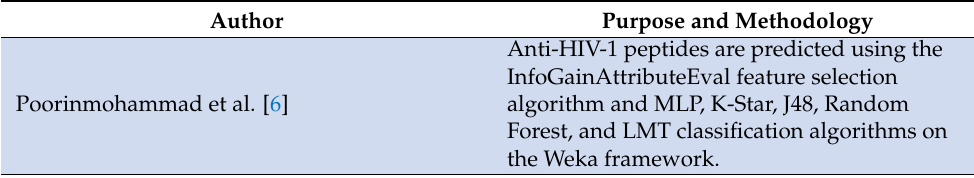
Table 1. Related work of this